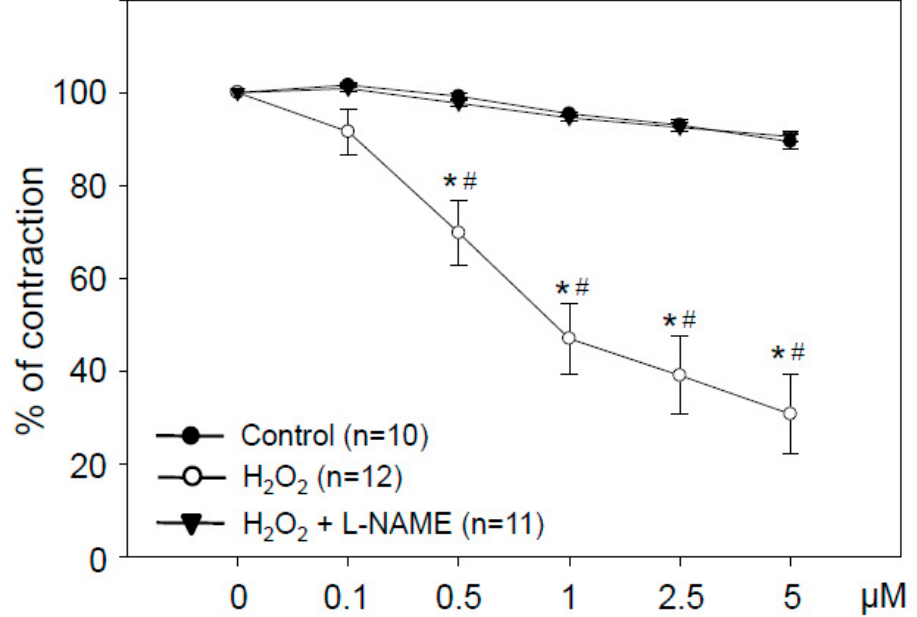
Figure 6. Hydrogen peroxide at low concentrations induces NO-dependent vasodilation. Aortic rings were treated with the indicated cumulative doses of H 2 O 2 . Selected rings were pretreated with the NOS-inhibitor N-nitro-L-arginine methyl ester (L-NAME, 100 µ M) before contraction by phenylephrine. Graphs show relaxation expressed as percentage of maximal phenylephrine-induced vasoconstriction. Control rings received the same amount of water. Data are means ± SEM of the indicated number of experiments. * p < 0.05 compared to the control; # p < 0.05 compared to H 2 O 2 + L- NAME.